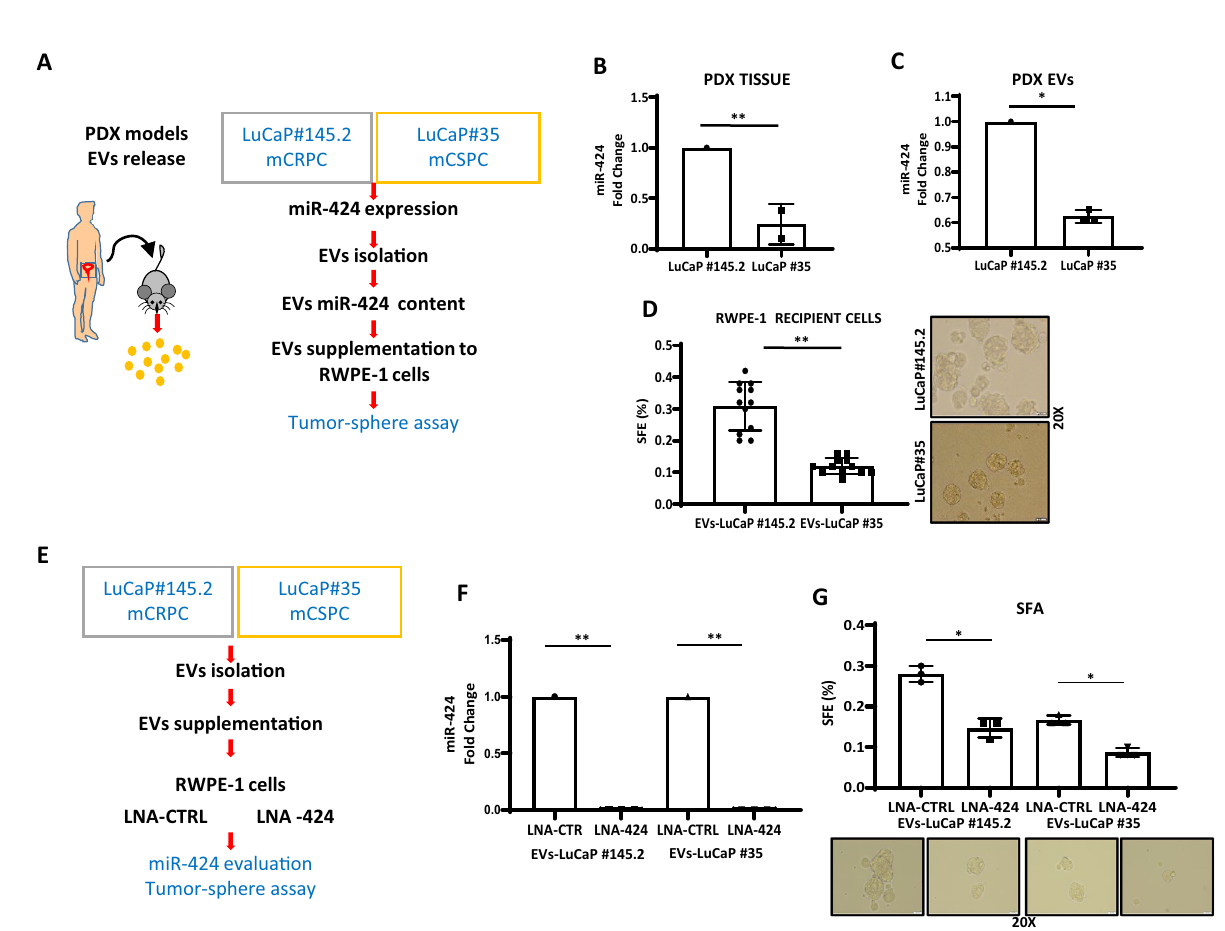
Fig. 6 EVs secretion of miR-424 is enhanced in aggressive prostate PDX and promote stemness in prostate epithelial cells. A Schematic plan to evaluate EVs release from LuCaP/PDX models and functional characterization. B miR-424 level in explants of LuCaP #145.2 (mCRPC) and LuCaP#35 (mCSPC) tumor xenografts ( n = 2/group). C Level of miR-424 evaluated in EVs derived from indicated PDX. D Tumor-sphere forming assay with RWPE-1 recipient cells incubated with mCRPC and mCSPC xenografts-derived EVs. E Schematic of the experimental plan to block miR-424 in recipient cells. F Level of miR-424 evaluated in recipient cells supplemented with EVs from the indicated PDX sources, following blockade of miR-424 using LNA-CTRL and LNA- 424. G SFE in RWPE-1 recipient cells transfected with LNA-CTRL and LNA-424 and subsequent supplementation with EVs from the indicated PDX sources. * p ≤ 0.05, ** p ≤